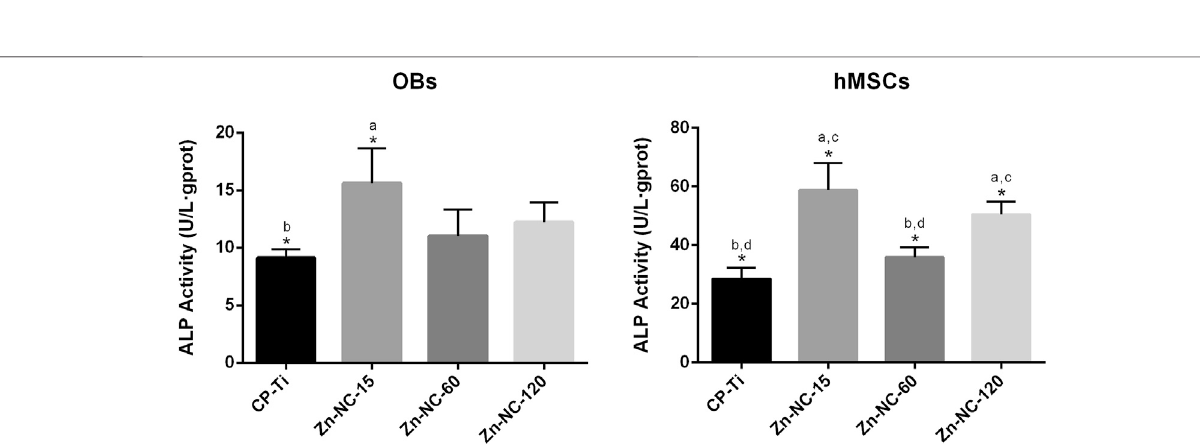
Frontiers in Materials |